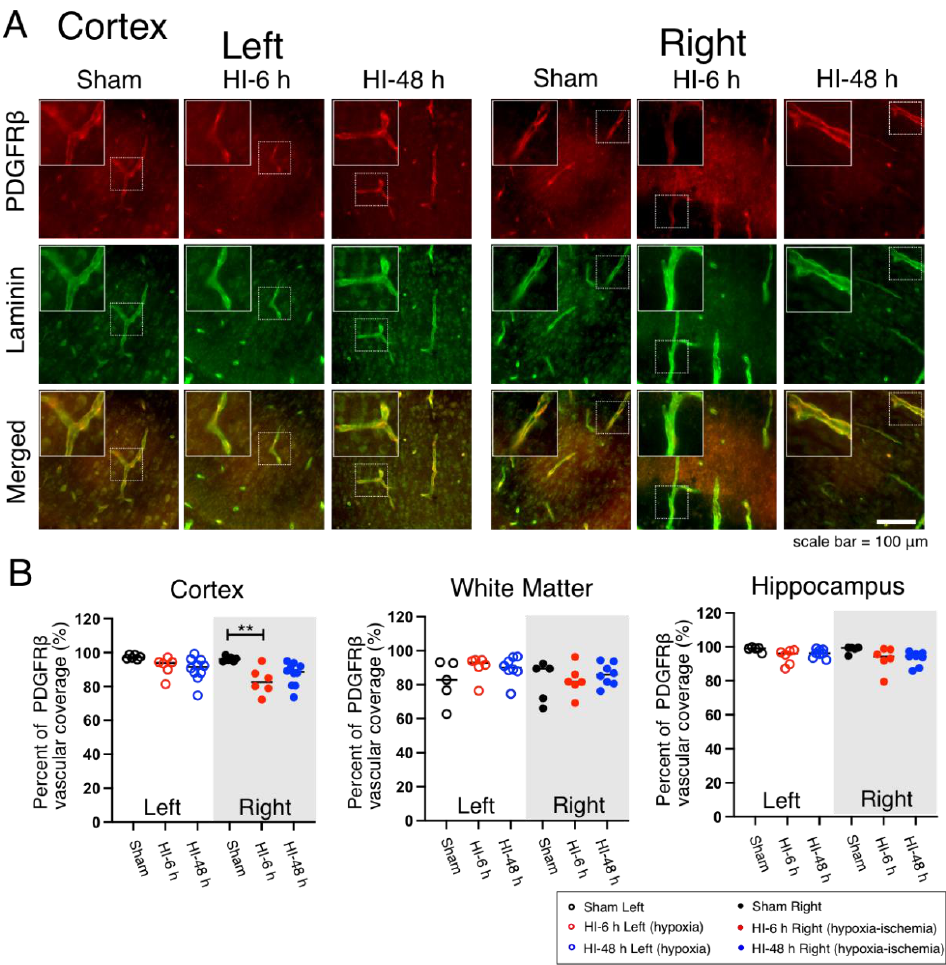
Figure 2. Immunohistochemical expression and quantification of pericyte coverage in the cerebral cortex, white matter, and hippocampus on the left hypoxic and right HI sides in the brain of the neonatal rats in the Sham, HI-6 h, and HI-48 h groups. ( A ) Representative images of pericyte (PDGFRβ, Red), microvessels (Laminin, Green) , and merged double immunostaining in the cerebral cortex of the neonatal rats. Magnification, 40×. Each inset contains high magnification images. Scale bar = 100 μm. The immunohistochemical images in white matter and hippocampus are shown in Supplemental Figure S1. ( B ) Quantification of pericyte coverage shown by percent of PDGFRβ vascular coverage in the cerebral cortex, white matter, and hippocampus of left hypoxic and right HI sides of rat brain in Sham (left; black open circles, right; black closed circles), HI-6 h (left; red open circle, right; red closed circles), and HI-48 h (left; red open circles, right; red closed circles). Values median and dot plots. ** p < 0.01